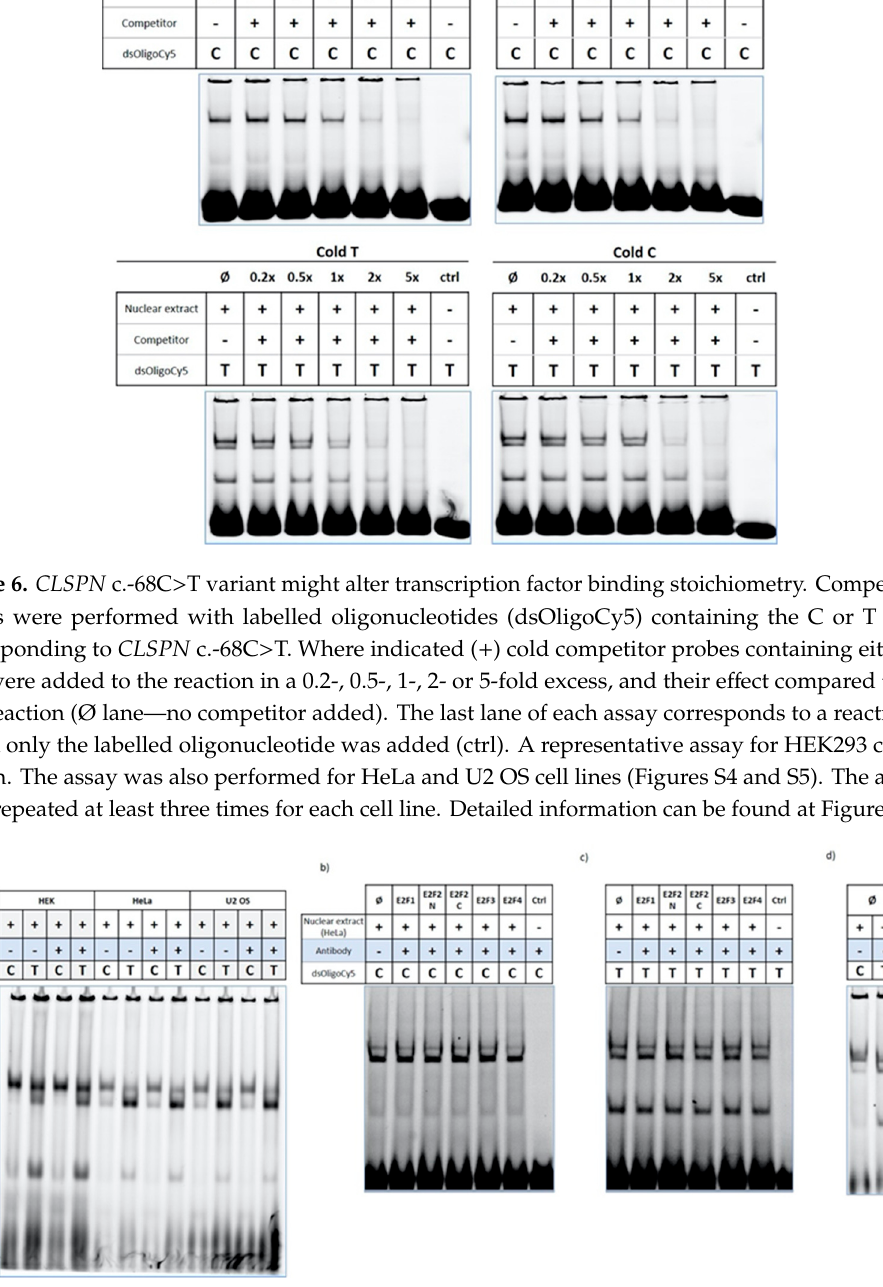
Figure 7. MyoD and E2F proteins do not bind to c.-68C>T site. No supershift was detected using anti-MyoD or anti-E2F antibodies. Where indicated (+) MyoD ( a ) or E2F antibodies ( b – d ) were added to the reaction and the effect compared with the reaction without the antibodies (lane Ø or -) for both alleles (C and T). The assays were repeated at least three times for HEK293, HeLa and U2 OS cell lines. A representative experiment is shown. E2F antibodies were tested either individually ( b , c ) or pooled ( d ). The last lane of each assay corresponds to reactions with oligonucleotides only (ctrl). Detailed information can be found at Figure S7.